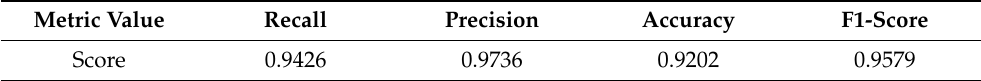
Table 3. Recall, Precision, Accuracy and F1-score for all lettuce